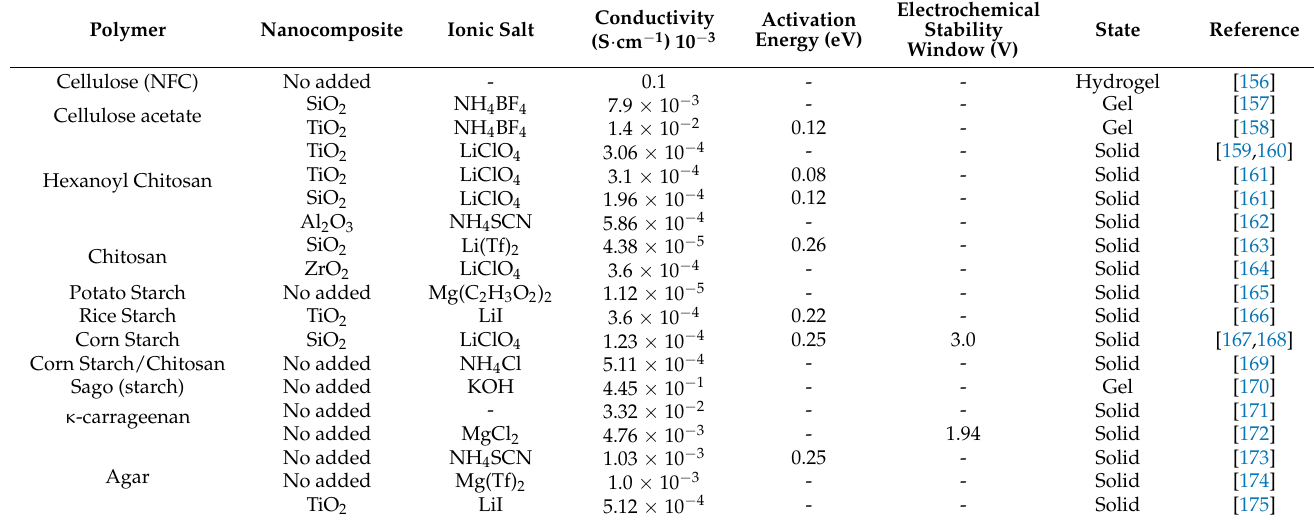
Table 8. Polymer electrolytes based on biopolymers for electrochemical applications. Polymer